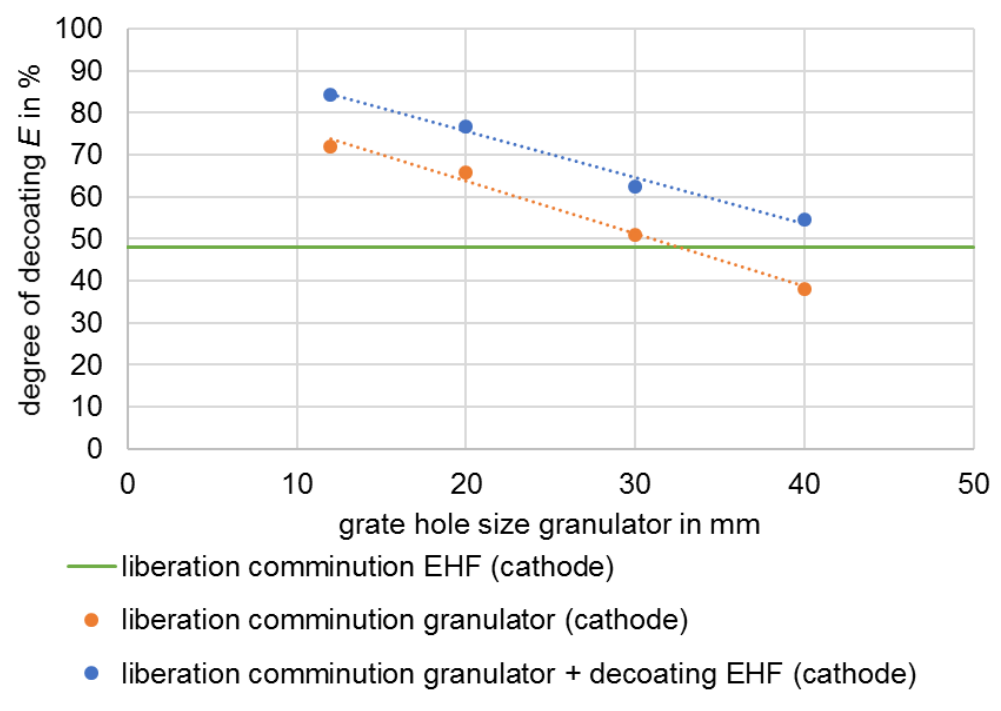
Figure 6. Degree of decoating E of the cathode after different stresses.